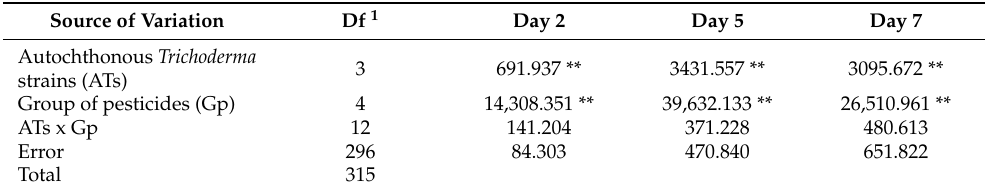
Table 3. Mean squares of two-way ANOVA (autochthonous Trichoderma strains and group of pesti- cides) for Trichoderma development.